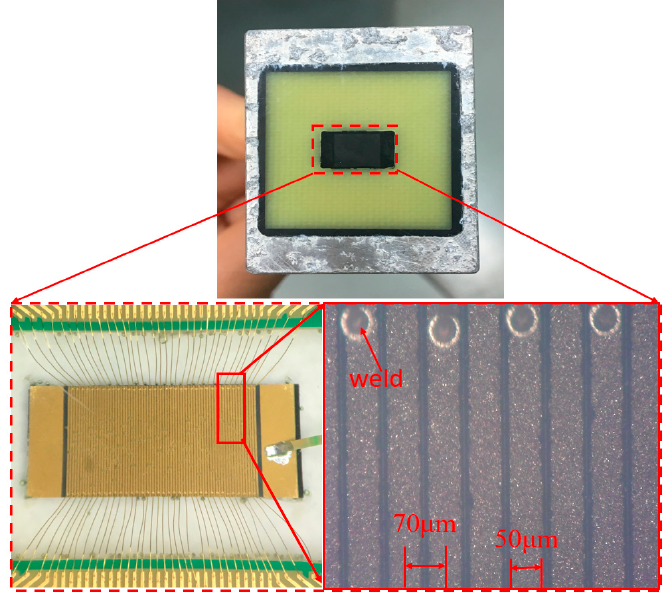
Figure 9. Fabricated transducer.